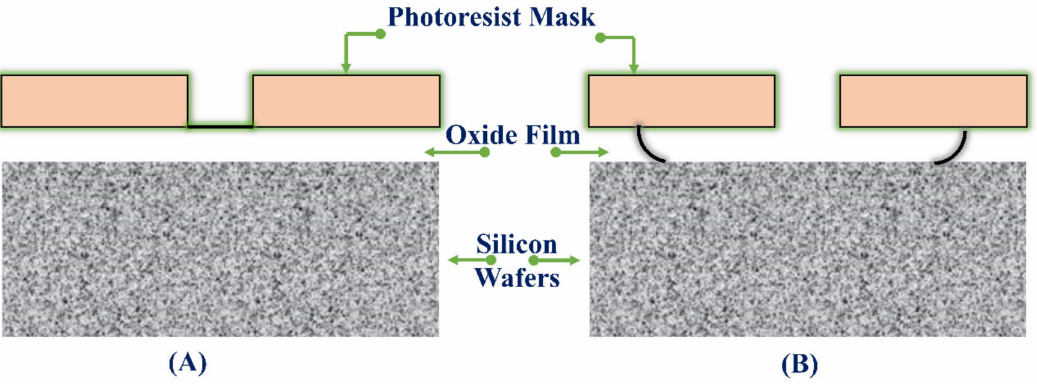
Figure 8. ( A ) Oxide film onto the silicon wafer with established photoresist mask, ( B ) after prolonged wet etching; the etch has developed under the mask (not to scale) [120]. (Reprinted from Ref. [120]). Rounded side wall microchannels are produced by isotropic wet chemical